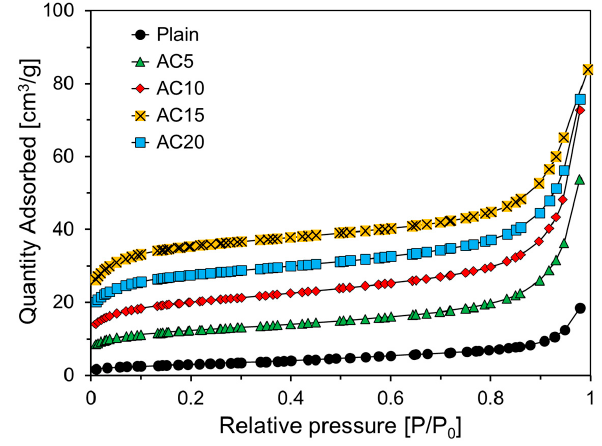
Figure 7. Nitrogen adsorption isotherm curves of foam composites.